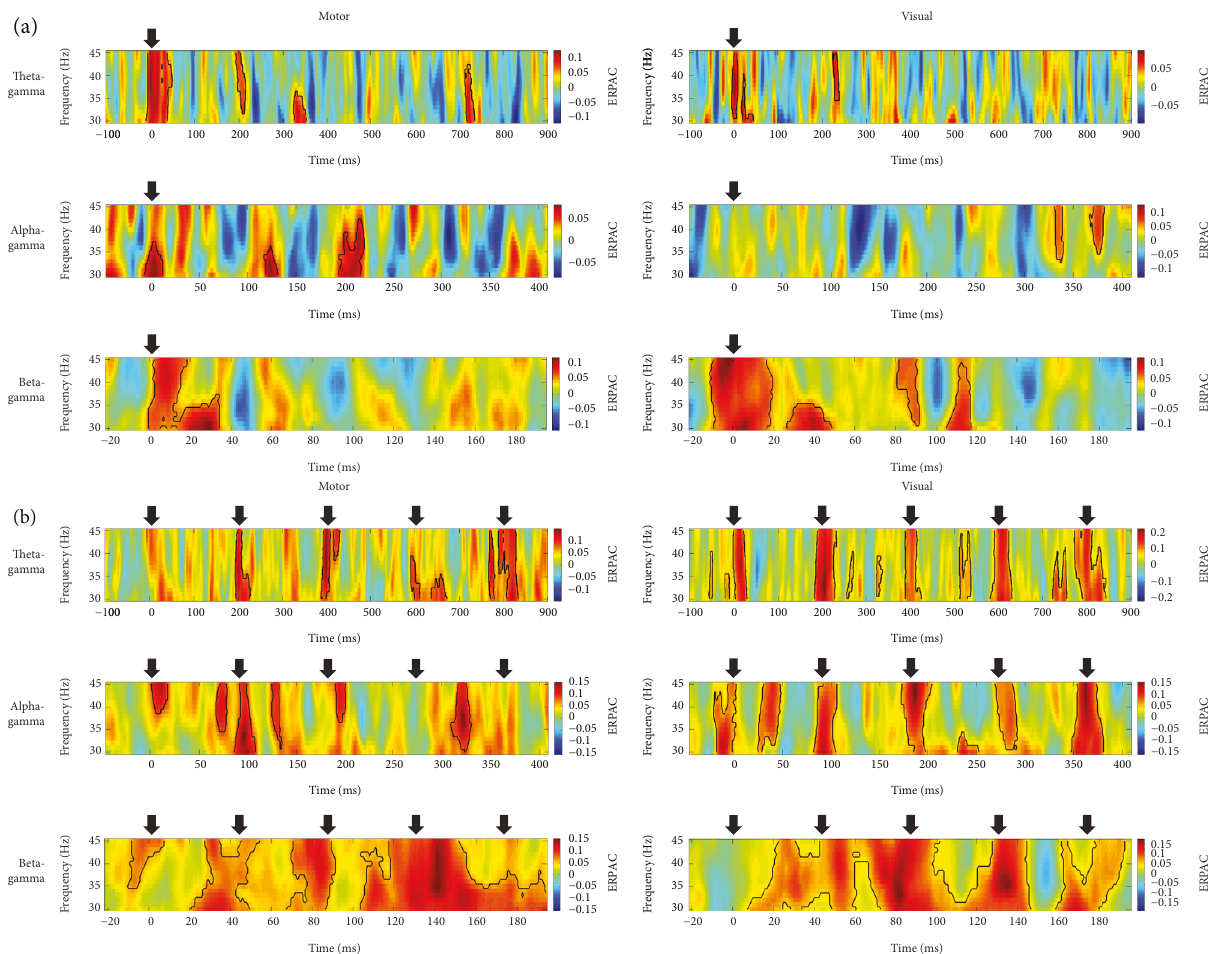
Figure 2: Grand average time-frequency representations of phase-amplitude coupling. Plots show the strength of motor-TMS-induced (left column) and visual-TMS-induced (right column) theta-gamma ( fi rst row), alpha-gamma (second row), and beta-gamma (third row) event-related phase-amplitude coupling (ERPAC) as a function of trial time and amplitude frequency. Stimulation paradigms are (a) sTMS and (b) rTMS, with the rTMS frequency always corresponding to the frequency of the phase series. We extracted TMS e ff ects by averaging ERPAC over electrodes C1 and C3 for motor TMS and electrodes Oz and O2 for visual TMS, subtracting corresponding mean data obtained during sham stimulation, and averaging the resulting values over the fourteen assessed participants. Time points of pulses are indicated by black arrows and signi fi cant time-frequency clusters ( p ≤ 05 , one-tailed cluster-based permutation tests) by black